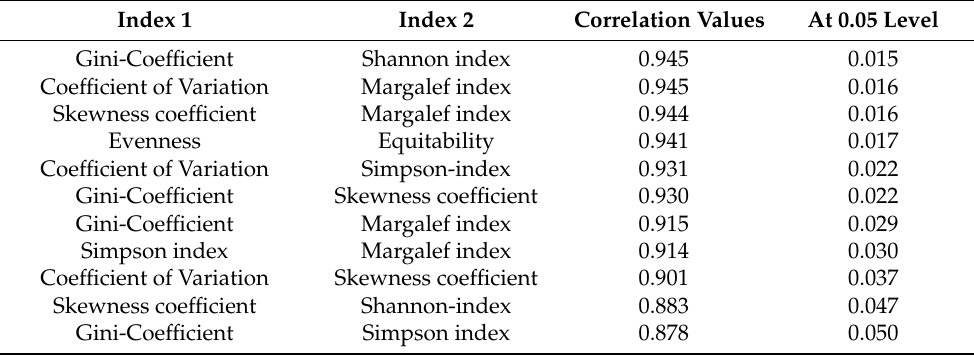
Table 6. Correlation statistics of the height inequality and diversity measures in the Valley-Bottom of the Omo Forest